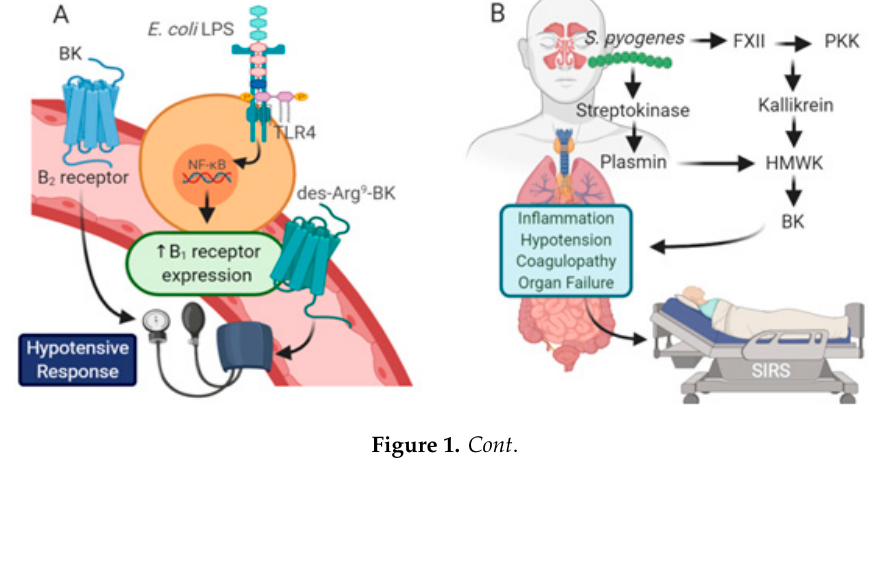
Figure 1. Relevance of components of the kinin system in bacterial infections. ( A ) E. coli LPS is a classical stimulus for kinin B 1 receptor induction in vascular tissues, likely contributing to